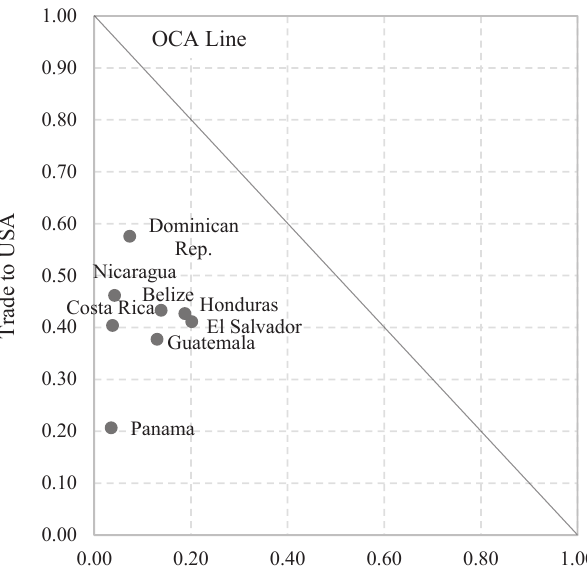
Figure 7. Costs and benefits